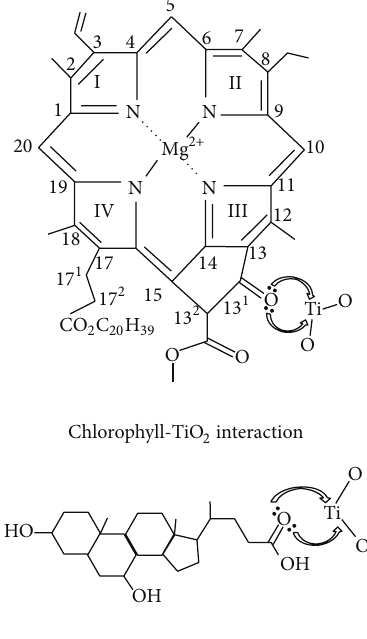
Figure 9: Chlorophyll-TiO 2 and CDCA-TiO 2 interaction on TiO 2 surface.